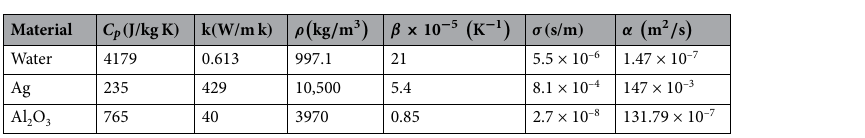
Table 1. Thermophysical properties of the base fluid and nanoparticles Ag/Al 2 O 3 (50%/50%) 12,38 .